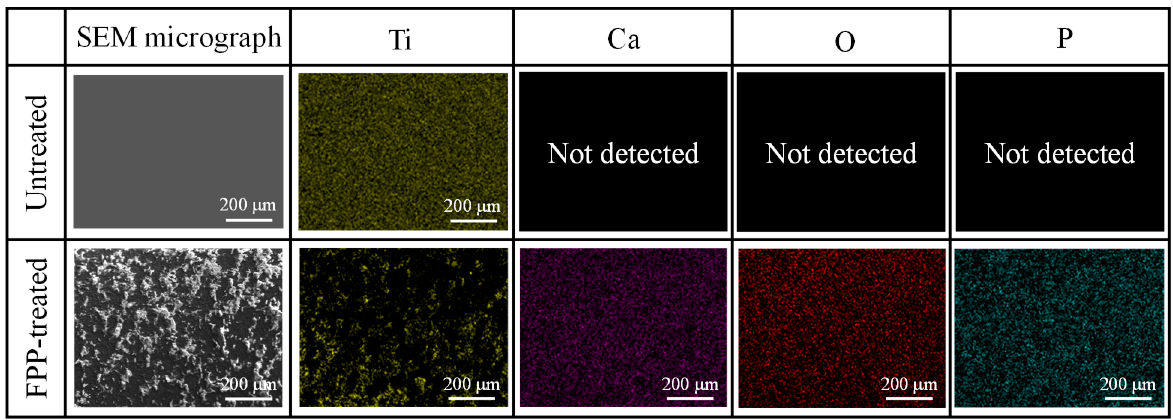
Figure 3. SEM micrographs and EDS maps for surface of untreated specimen and FPP-treated specimen.